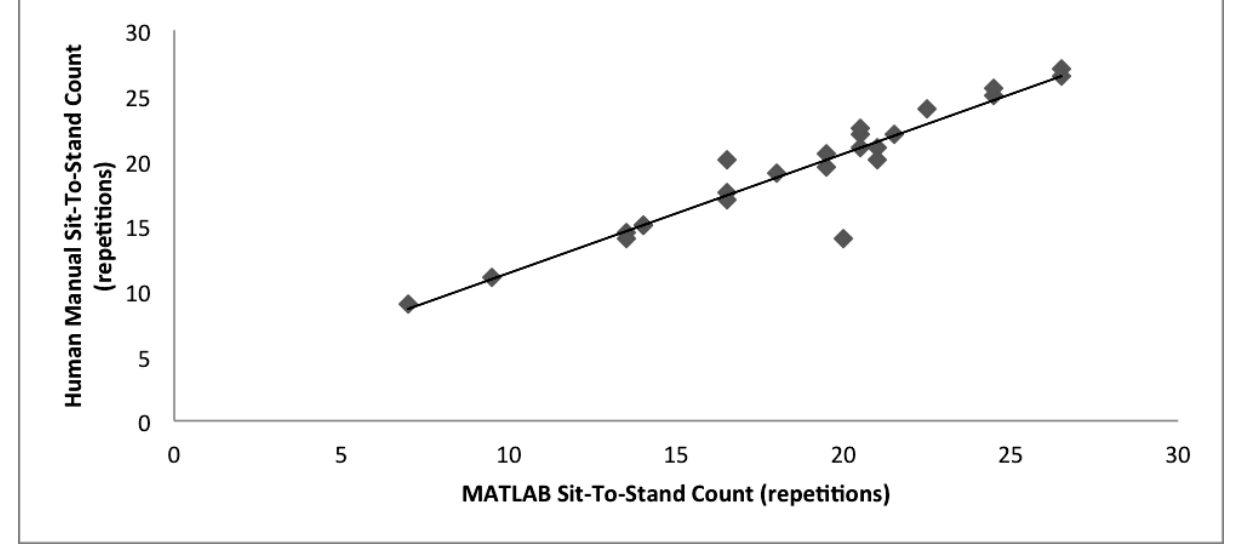
Figure 5. Regression between MATLAB computation and manual count in calculation of 30-second Chair Stand Test repetitions (n=24; Pearson’s correlation coefficient=.890).